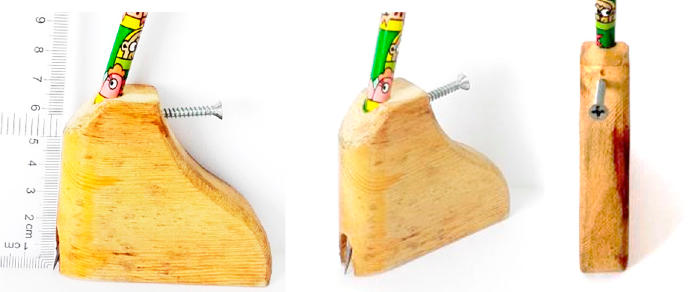
Figure 1. Design and characteristics of a newly designed measurement device.